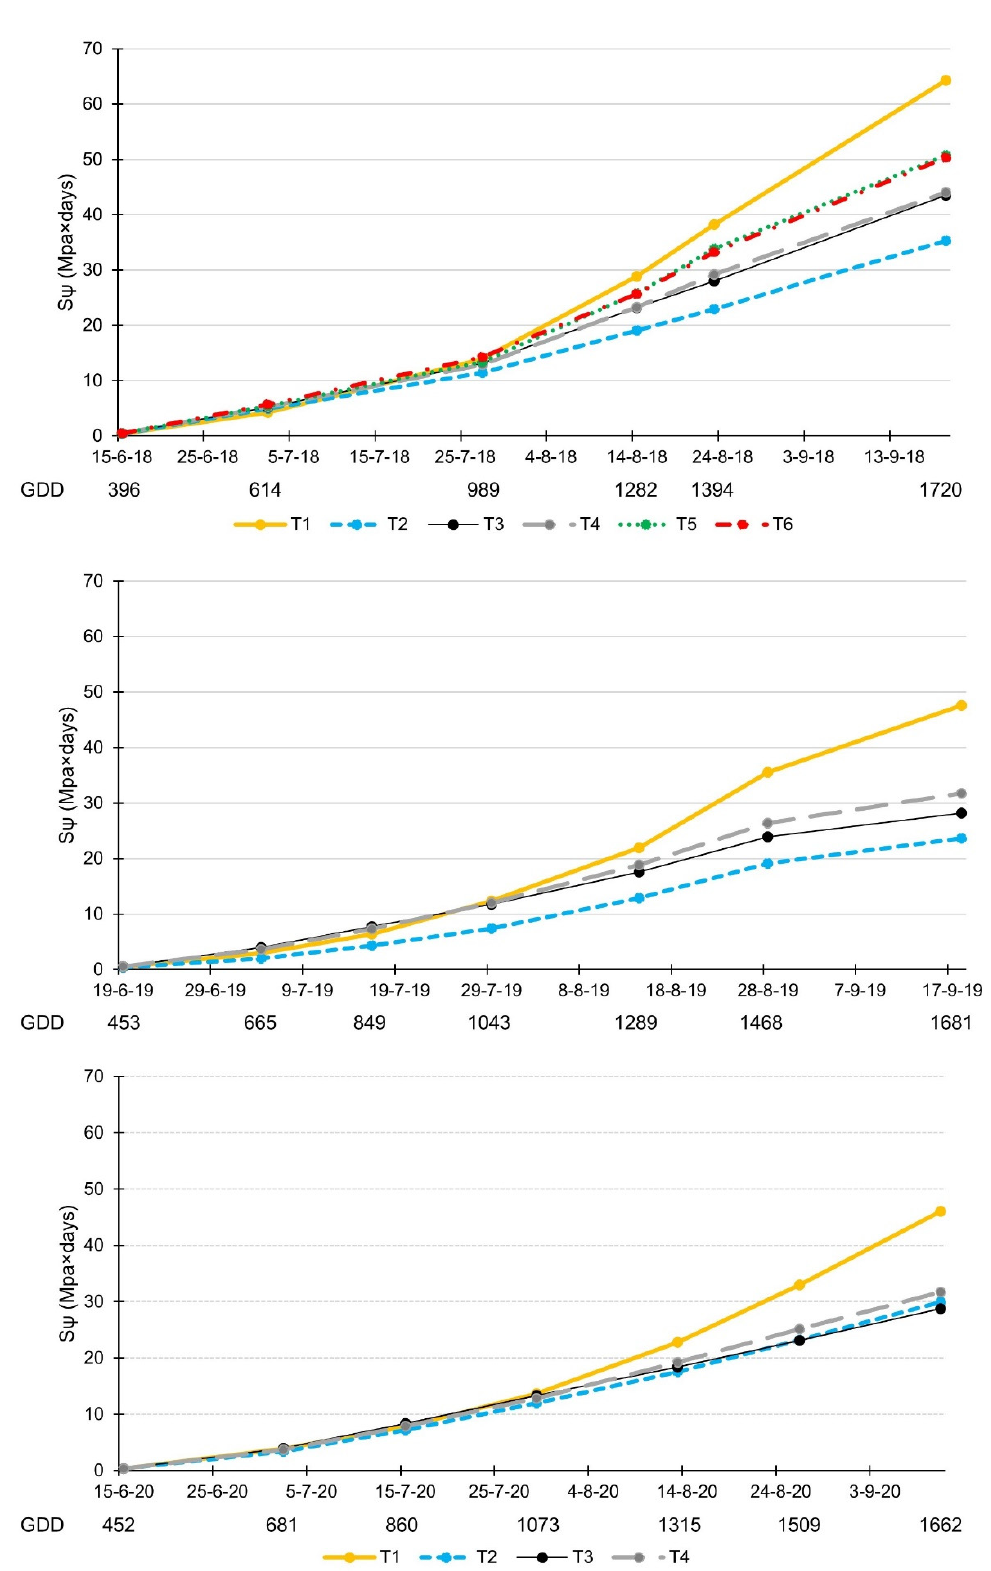
Figure 5. Water stress integral (S ψ ; MPa×days) of studied vineyard located in Fuente-Álamo, Spain, for different experimental treatments during the 2018, 2019, and 2020 seasons. GDD: growing degree days of measurement and flight dates in each year.